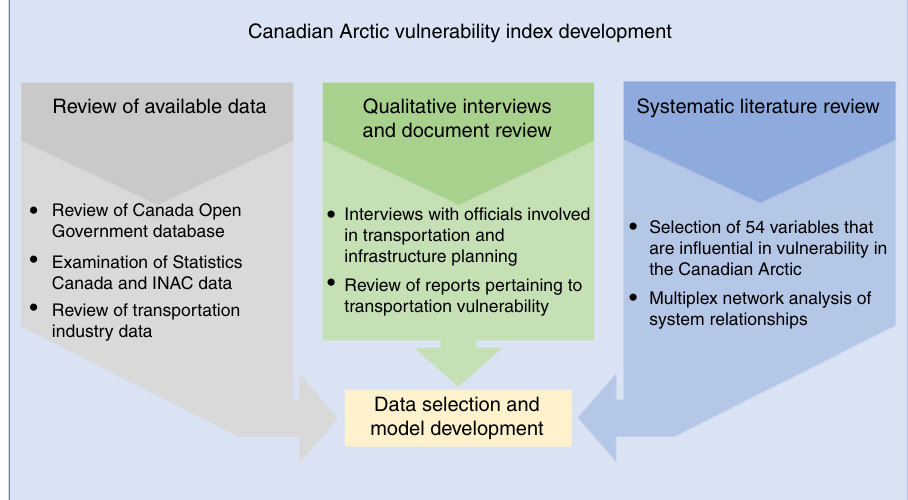
Fig. 6 Development of the Arctic Climate Change Vulnerability Index for Northern Aviation, Shipping, and Infrastructure followed an iterative and parallel process. The method also emphasized incorporating regional and local knowledge from the large region through a systematic literature review and